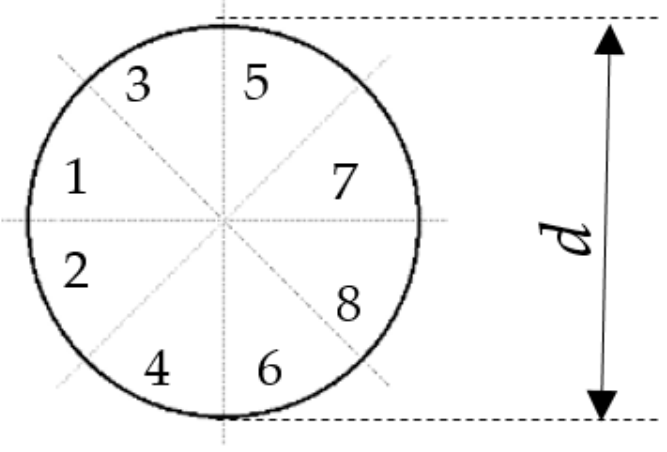
Figure 2. The basic vortex shedder shape.